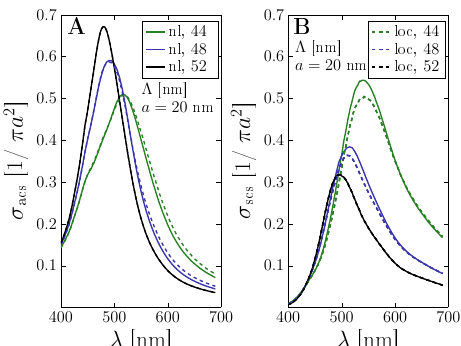
Figure 3. Impact of nonlocal effects on a gold nanoparticle array with a = 20 nm. Normalized ( A ) absorption ( σ acs ) and ( B ) scattering cross section ( σ scs ) are shown for several inter-particle distances Λ comparing classical ( loc , dashed) and nonlocal ( nl , solid) electron dynamics.